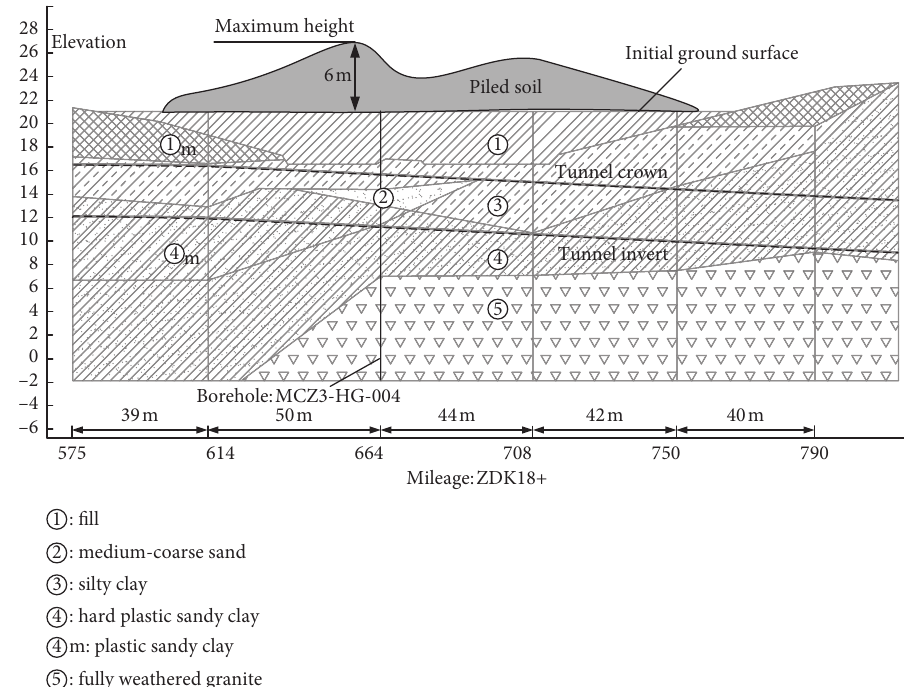
Figure 19: The detailed soil profile along the longitudinal direction.